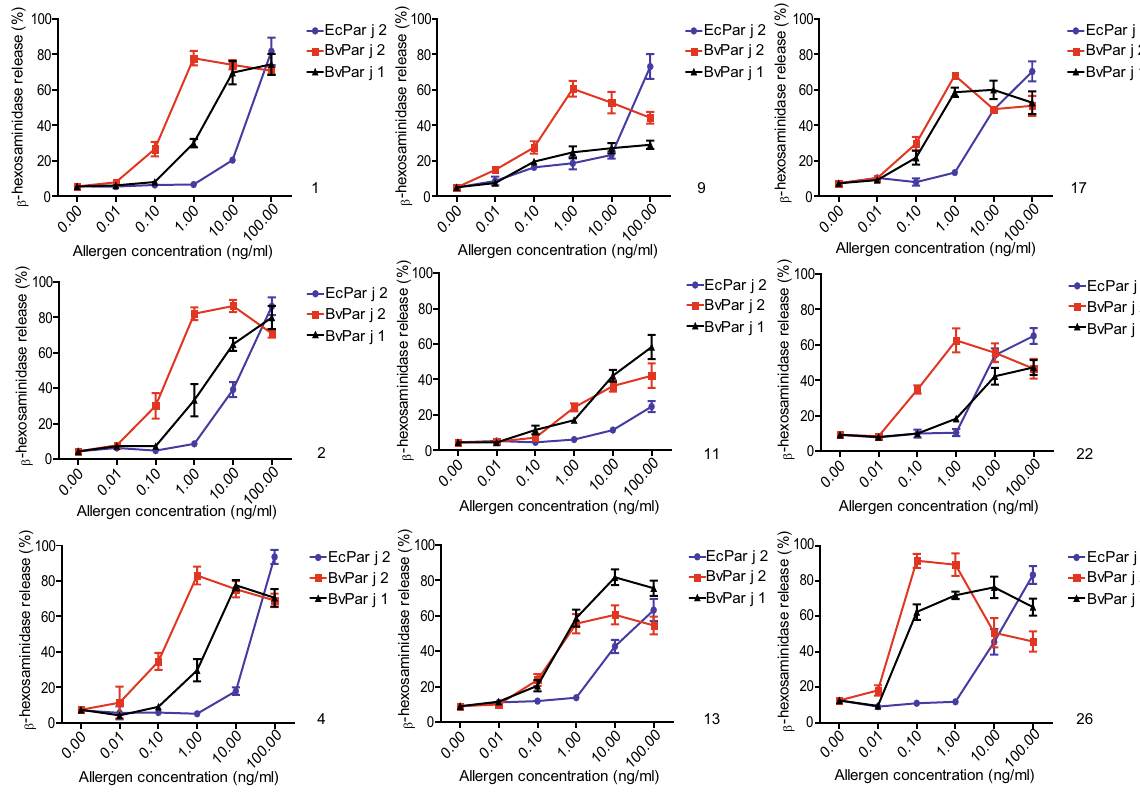
Figure 5. Comparison of the allergenic activity of BvPar j 1, BvPar j 2 and EcPar j 2. RBL cells were loaded with sera from nine Parietaria allergic patients (1, 2, 4, 9, 11, 13, 17, 22, 26) and stimulated with different allergen concentrations (x-axes). β -hexosaminidase releases are expressed as percentages of total mediator contents + / − SD (y-axes).